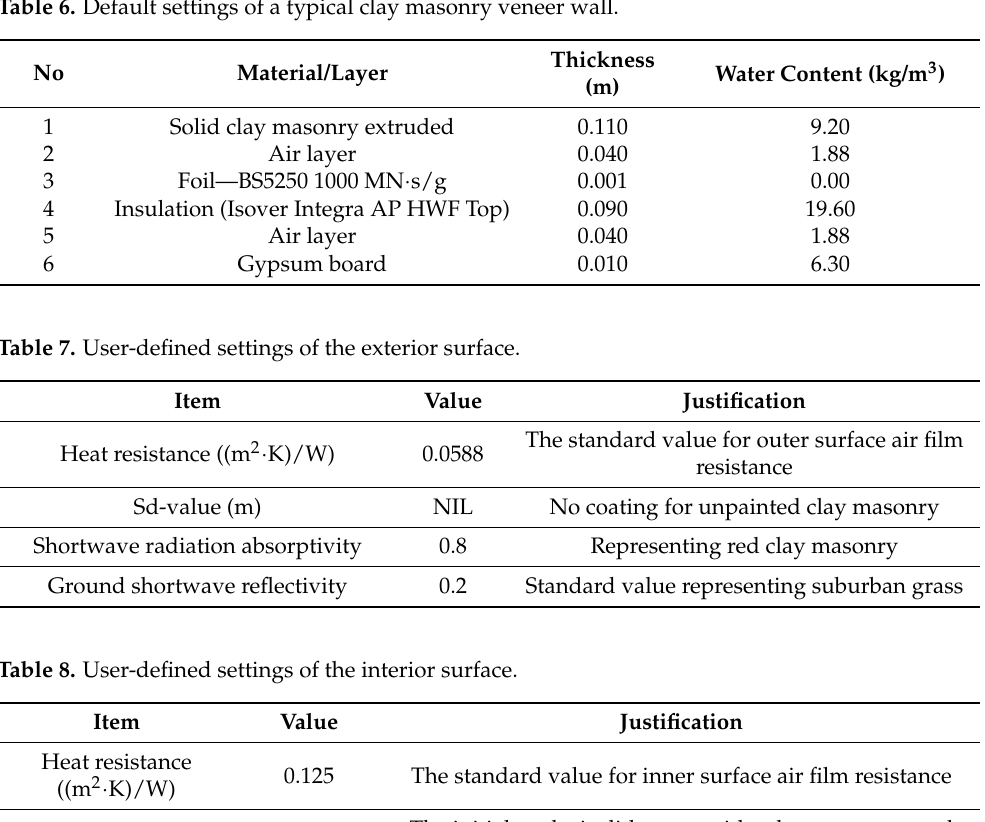
Table 6. Default settings of a typical clay masonry veneer wall.